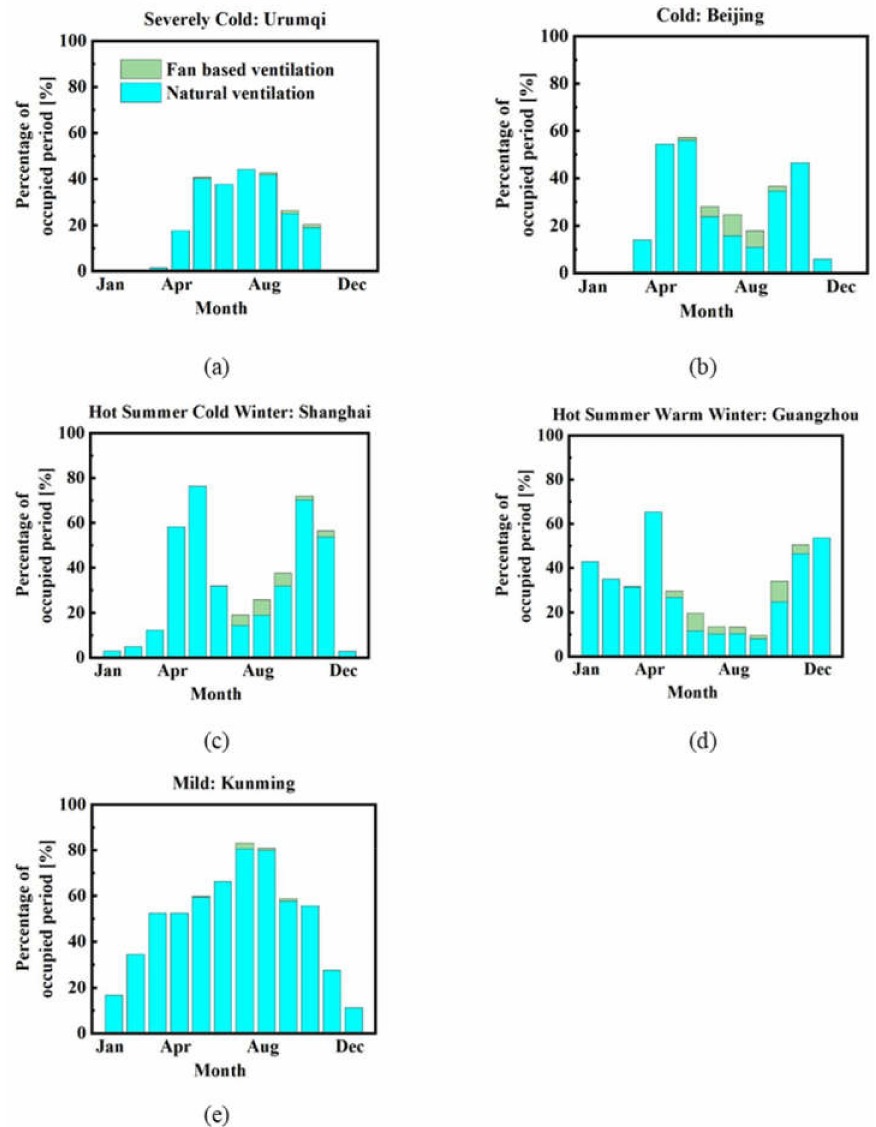
Figure 5. Percentage of occupied period in each month when natural ventilation and purely fan-based ventilation were sufficient to maintain an acceptable indoor thermal environment, when the indoor equipment load is 15 W/m 2 in different climate zones: ( a ) severely cold; ( b ) cold; ( c ) hot summer cold winter; ( d ) hot summer warm winter; ( e )